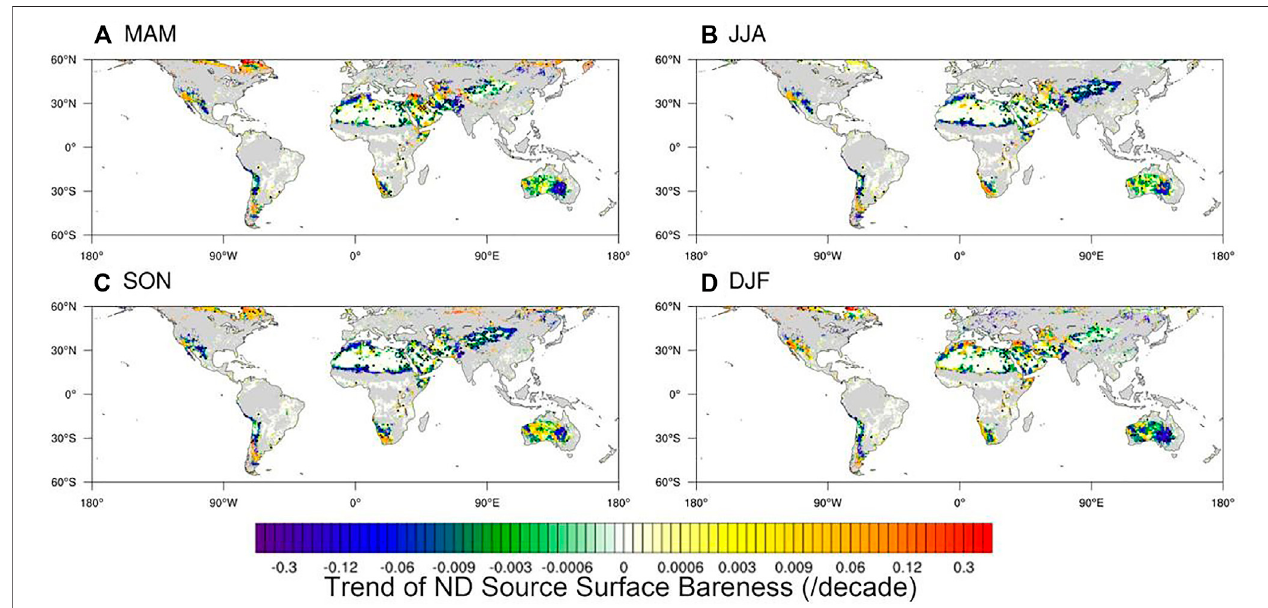
FIGURE 3 | Trend of the seasonal ND surface bareness during 2001 – 2018. The dotted regions with statistically signi fi cant above the 90% con fi dence level are indicated.